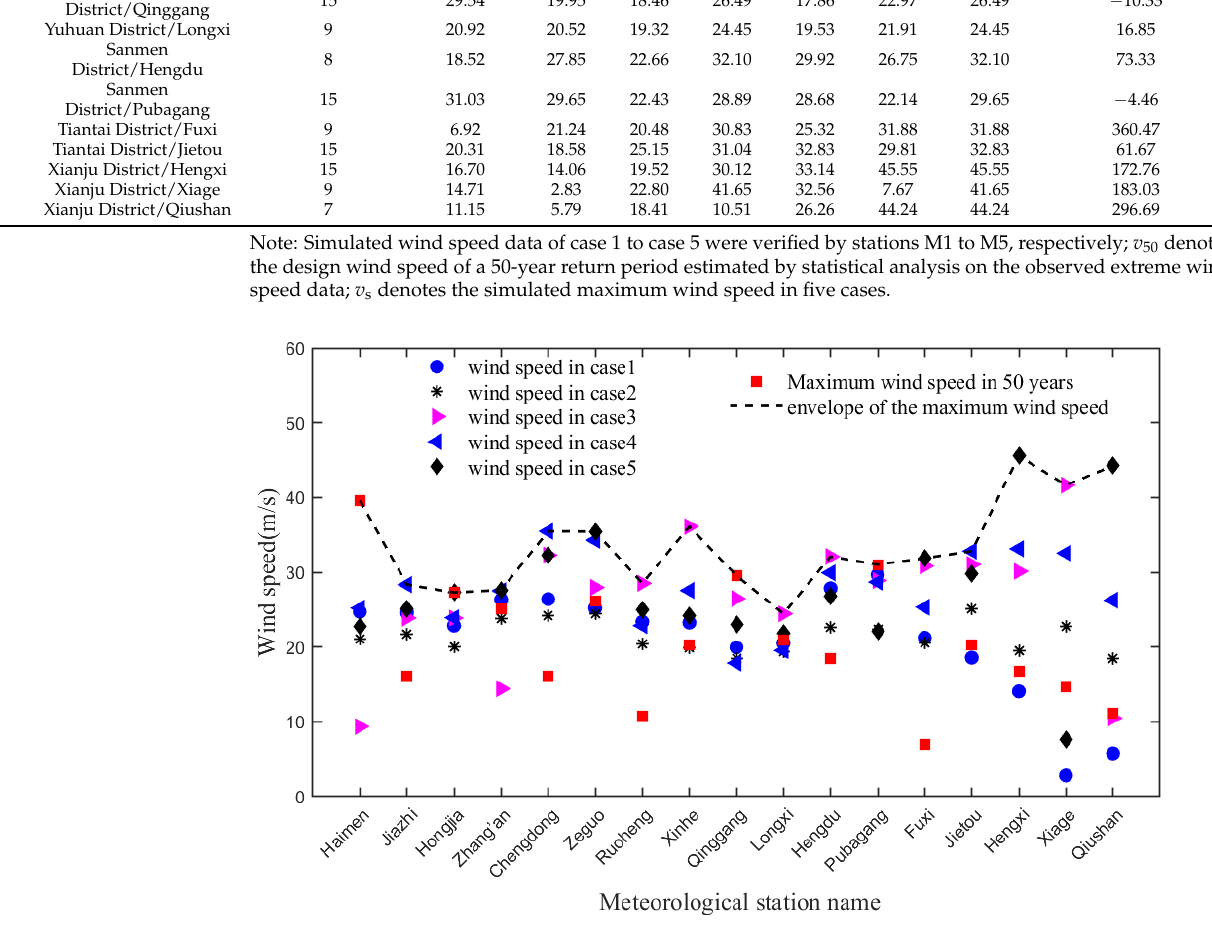
296.69 Note: Simulated wind speed data of case 1 to case 5 were verified by stations M1 to M5, respec- tively; v 50 denotes the design wind speed of a 50-year return period estimated by statistical analy- sis on the observed extreme wind speed data; v s denotes the simulated maximum wind speed in five cases. According to the meteorological records, in the past 19 years, only in 2019 did Ty- phoon Lekima land in Taizhou directly. A large number of new meteorological stations have since been built with a relatively short history, but few data have been collected due to typhoon. It is difficult to estimate a reasonable 50-year return period design wind speed with the short-term observation data. This work provides an alternative mesoscale CFD simulation method to directly simulate the extreme mean wind speed with calibra- tion to the reference design wind speed estimated from the reliable observation data of the main stations. The wind pressure was then calculated according to the simulated maximum wind speed by Equations (9)–(10). The reference wind pressure of w 1 for a specific site could be determined as the larger one between the wind pressure from the simulation ( w s ) and the